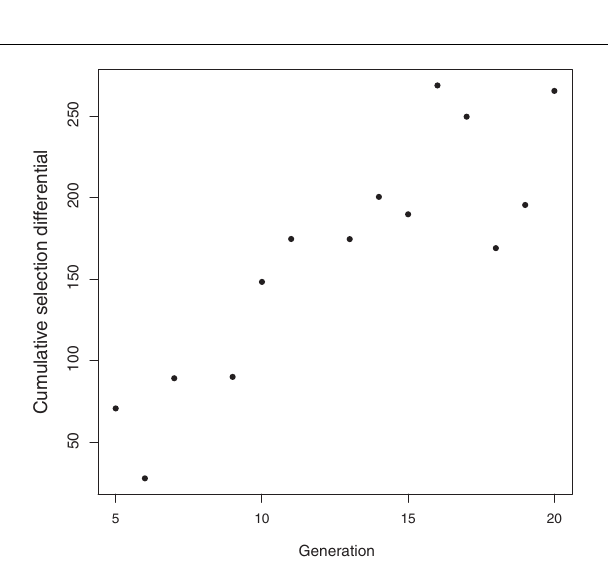
when a population bottleneck occurs (Reich et al., 2001).